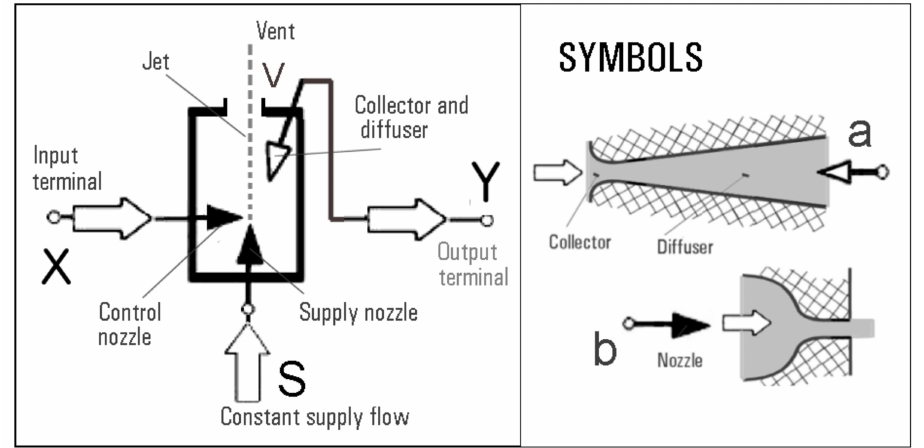
Figure 4. The principle of jet-deflection type fluidic amplifier. The fluid flow is accelerated in a nozzle (usually before its leaving closed cavities as a jet) and decelerated in a di ff user (usually downstream from the collector capturing the